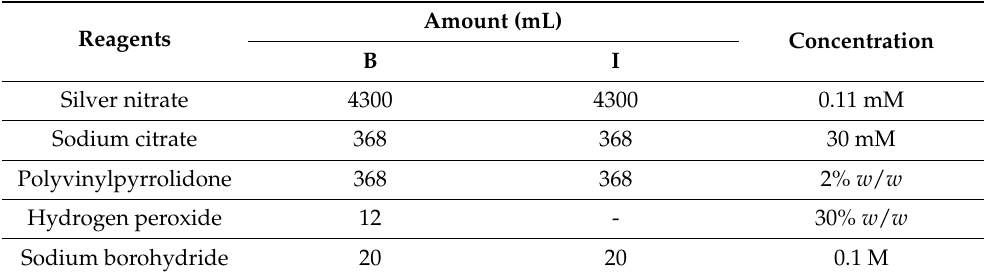
Table 1. Concentrations of the